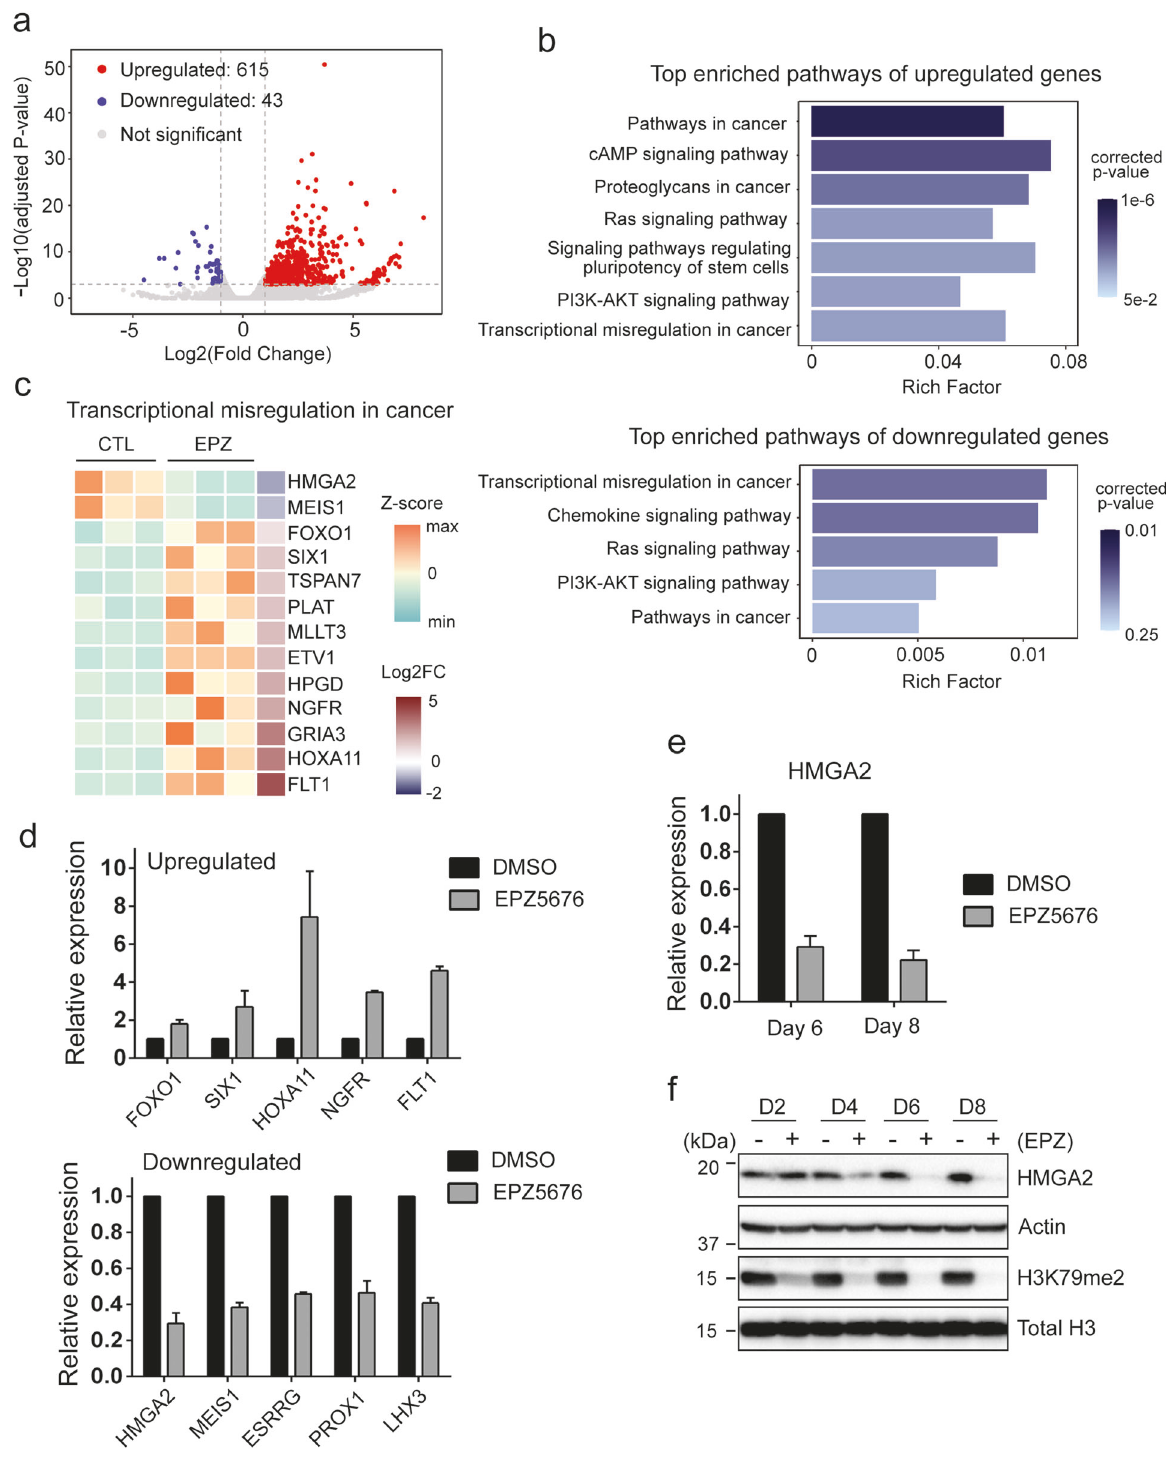
Fig. 3 HMGA2 expression is downregulated by DOT1L inhibition. a Volcano plot of DEGs in EPZ5676-treated Y79 cells in comparison to vehicle-treated cells. b KEGG pathway enrichment analyses for upregulated and downregulated DEGs. Cancer-related pathways are shown from the top 20 enriched pathways ranked by p -values before correction. The Rich Factor indicates the gene count ratio of DEG/annotated genes belonging to each pathway term listed. c Heat map of DEGs belonging to the KEGG pathway term of transcriptional misregulation in cancer. Each column represents an independent replicate. d qRT-PCR analysis for the relative expression of indicated DEGs in Y79 cells treated with 10 µM EPZ5676 for 6 days. The bar graph is shown as the mean ± SD of fold changes, relative to the vehicle-treated group ( N = 3). e , f Expression of HMGA2 determined by qRT-PCR ( e ) and immunoblot ( f ) analyses for Y79 cells treated with 10 µM EPZ5676 for the indicated days. The bar graph represents the mean ± SD of fold changes ( N = 4).